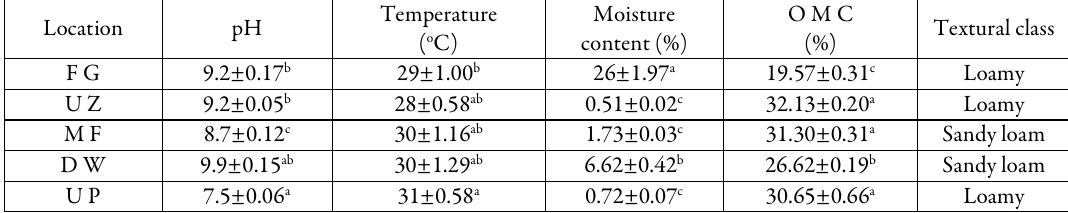
Table 2 . Percentage frequency of occurrence of Actinomycetes isolated from locations in Ilorin metropolis